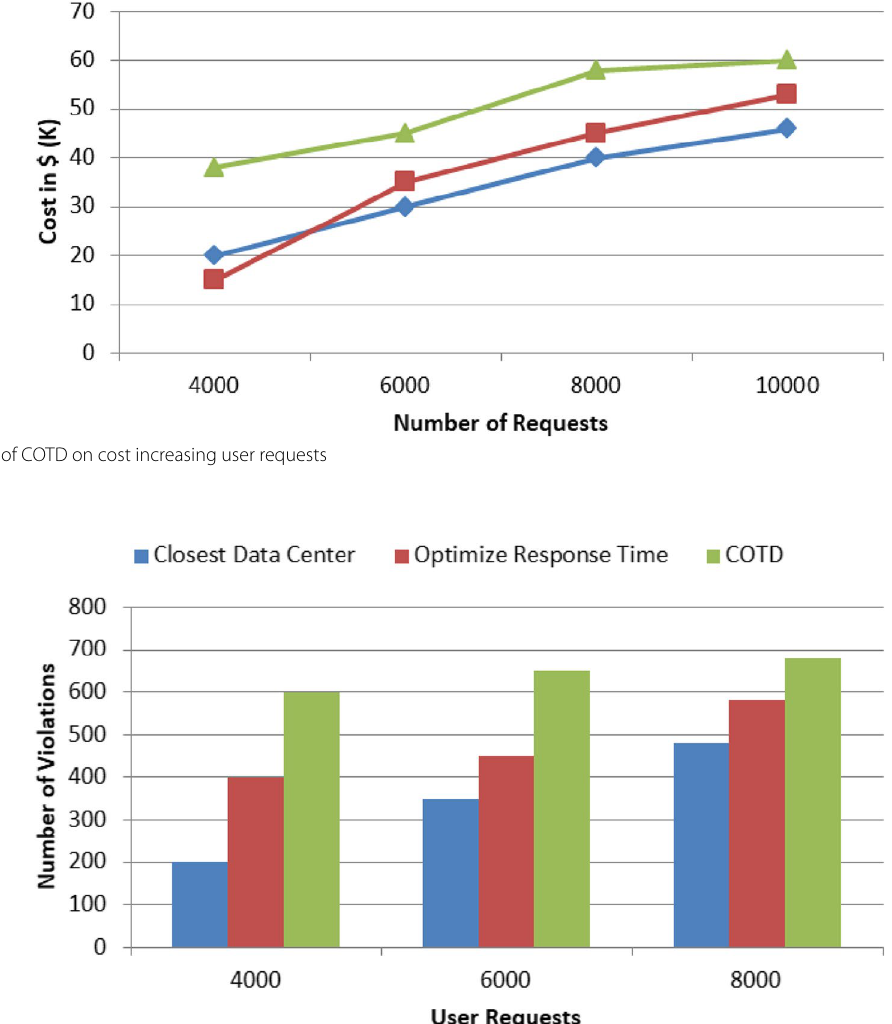
algorithmand SPBR and POR methods. The proposed algorithm perfroms better as the deadline violations of user requests are less as compared to other algorithms.